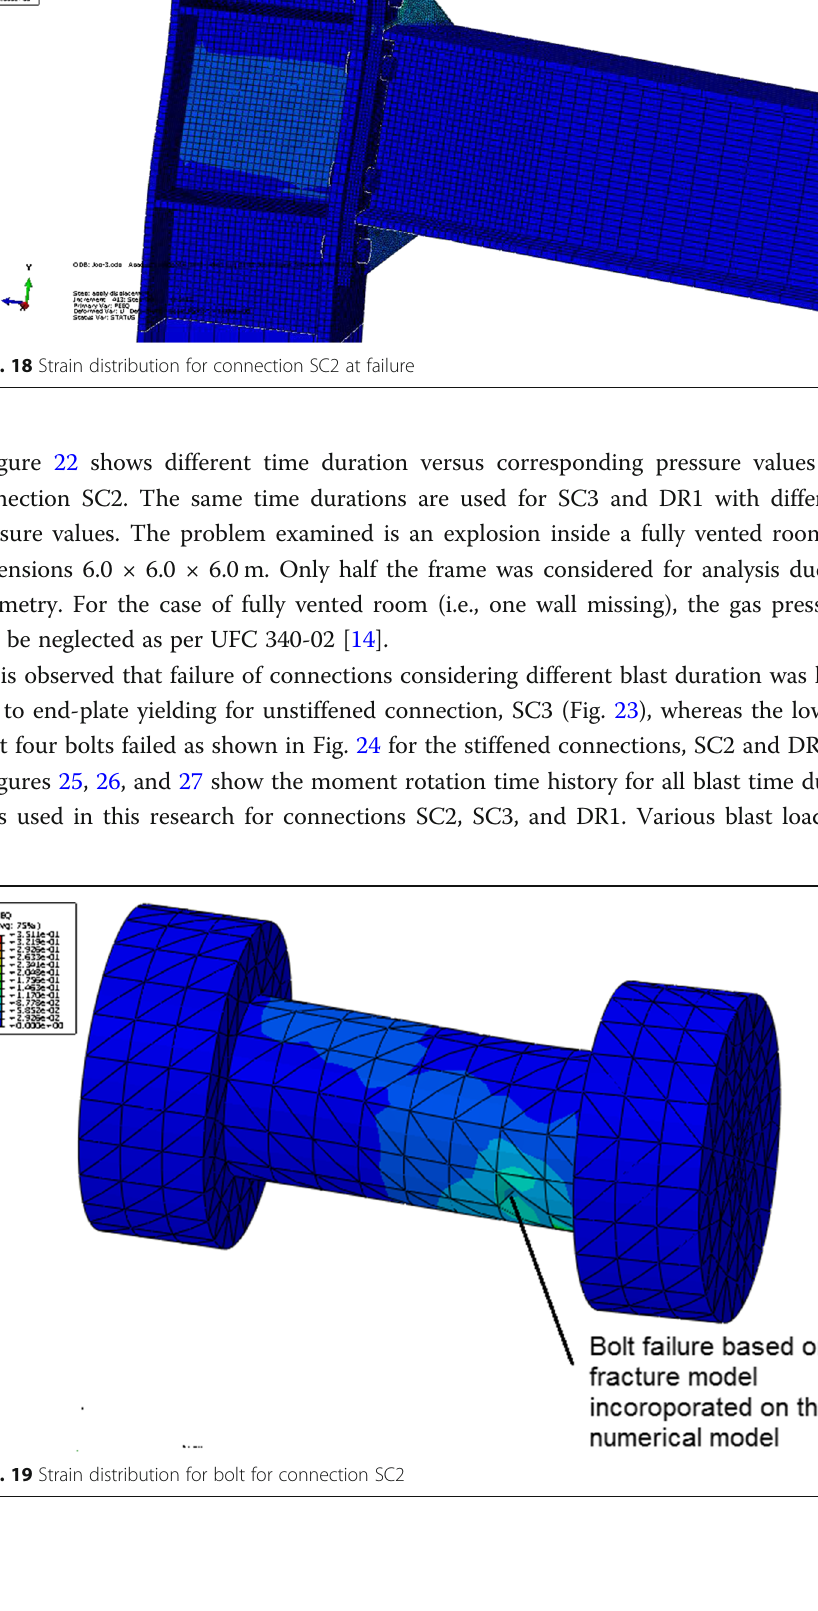
Fig. 19 Strain distribution for bolt for connection